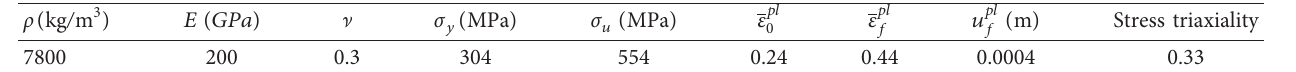
Table 1: Material failure parameters used in present numerical